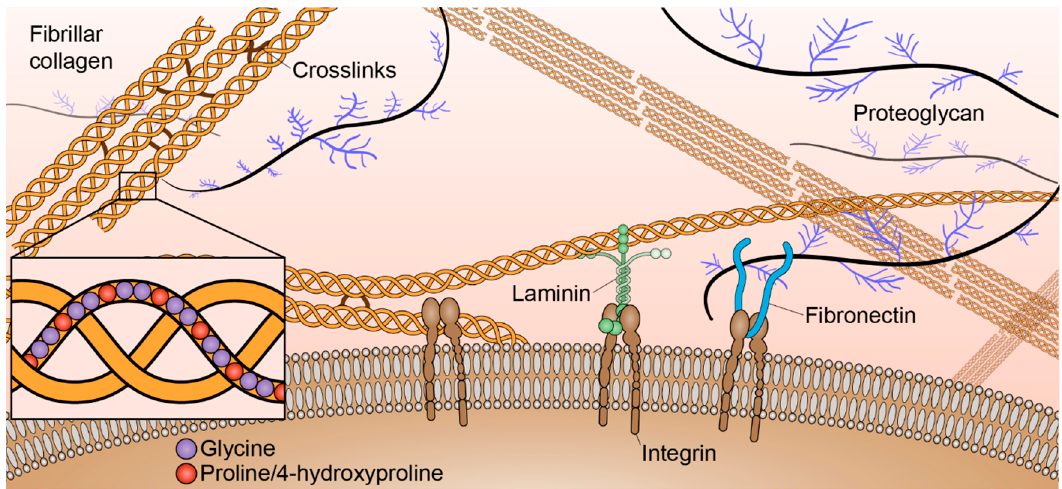
Figure 1. Key extracellular matrix (ECM) components of the tumor microenvironment. Collagens, laminin, fibronectin, proteoglycans, and other components are produced by fibroblasts and other resident cells.